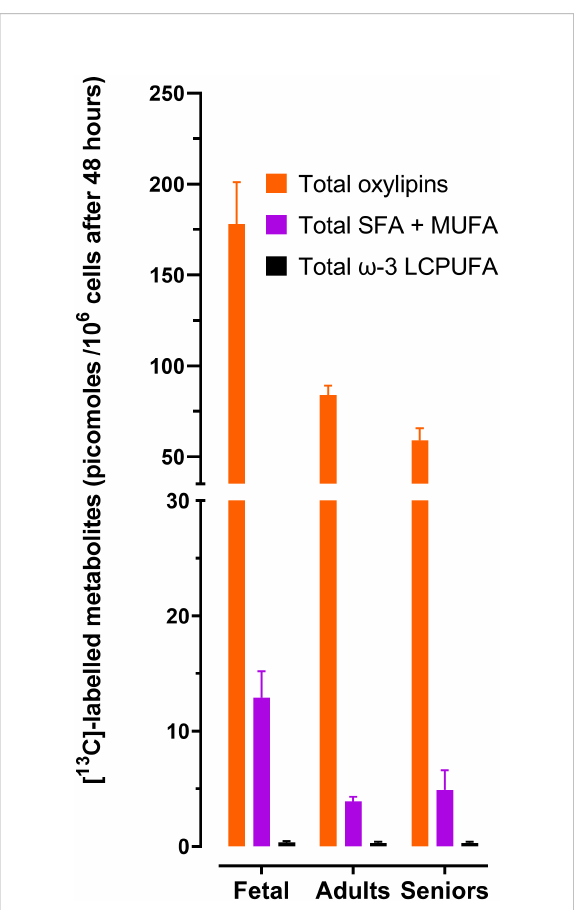
FIGURE 1 Summary of the effect of life stage on the amounts total [ 13 C]- labelled 18:3 w -3 – derived metabolites in CD3 + T lymphocytes. Values are the mean ± SEM of each [ 13 C]-labelled fatty acid class in unstimulated plus stimulated T cells according to life stage. Data and statistical comparisons are shown in Tables 2, 3. LCPUFA, long-chain polyunsaturated fatty acids; MUFA, monounsaturated fatty acids; SFA, saturated fatty acids. Total oxylipins were the sum of [ 13 C]-9-HOTrE, [ 13 C]-13-HOTrE, [ 13 C]- 9,10-DIHODE, [ 13 C]-12,13-DiHODE, plus [ 13 C]-15,16-DiHODE. Total LCPUFA were the sum of [ 13 C]20:3 w -3,[ 13 C]20:5 w -3, [ 13 C] 22:5 w -3 plus [ 13 C]22:6 w -3. Total SFA + MUFA were the sum of